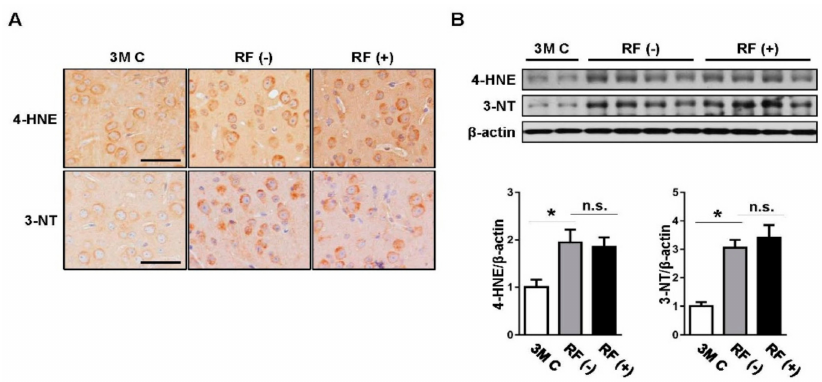
Figure 1. Effects of long-term RF-EMF exposure on induction of oxidative damage in aged mouse brains. ( A ) Representative images of lipid peroxidation (4-HNE, upper panel) and protein nitration (3-NT, lower panel) staining in the young-aged (3M C, n = 3), sham-exposed (RF ( − ), n = 6), and RF-exposed (RF (+), n = 6) mouse brain. Scale bar: 50 µ m. ( B ) Western blot images and subsequent quantification graph of 4-HNE and 3-NT. The values are presented as means ± standard error of the mean (SEM). * p < 0.05 versus young-aged (3M C) group. n.s.: no significance.